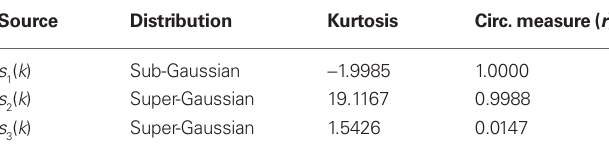
Frontiers in Neuroscience |